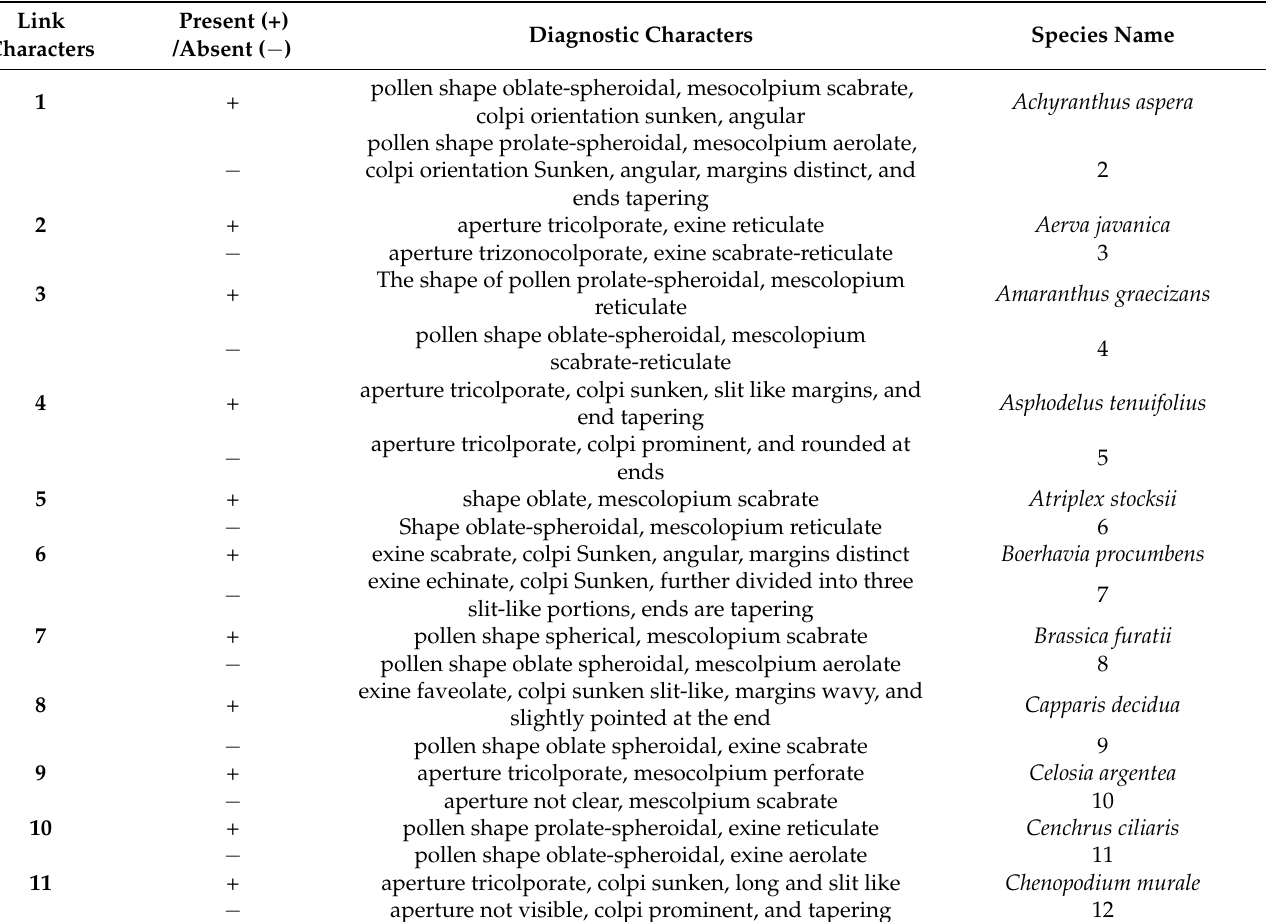
Table 5. Dichotomous key for identifying the Pothor (Pakistan) weed species based on the pollen morphological